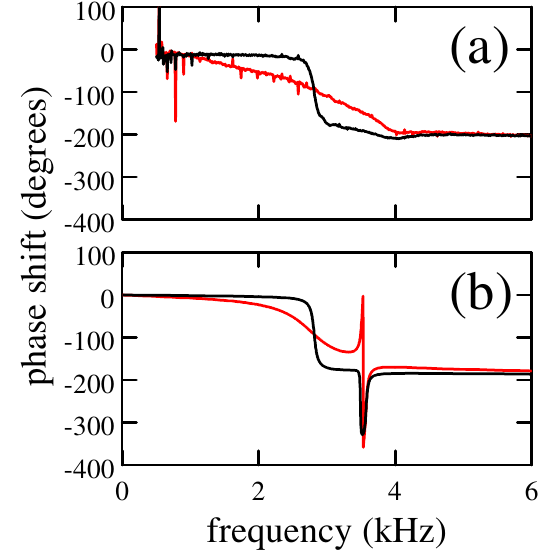
FIG. 9. (Color) Operation with passive harmonic-cavity voltage equaling 119% of that required for optimal bunch lengthening. In this case, a double-hump bunch is confined in a synchrotron potential with two minima. Black curves: phase feedback off. Red curves: phase feedback on. (a) Experimental measurement of the transfer function amplitude. (b) Transfer function ampli- tude calculated with the beam energy spread equaling its natural value.